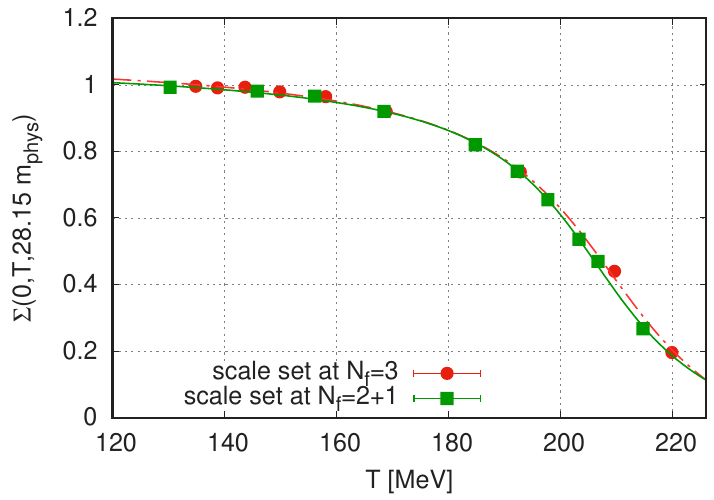
Figure 2 . Comparison of the two scale setting procedures described in the text. Red circles indicate the results using the w 0 scale at the N f = 3 point, while the green squares correspond to the 2 + 1-(cid:13)avor LCP